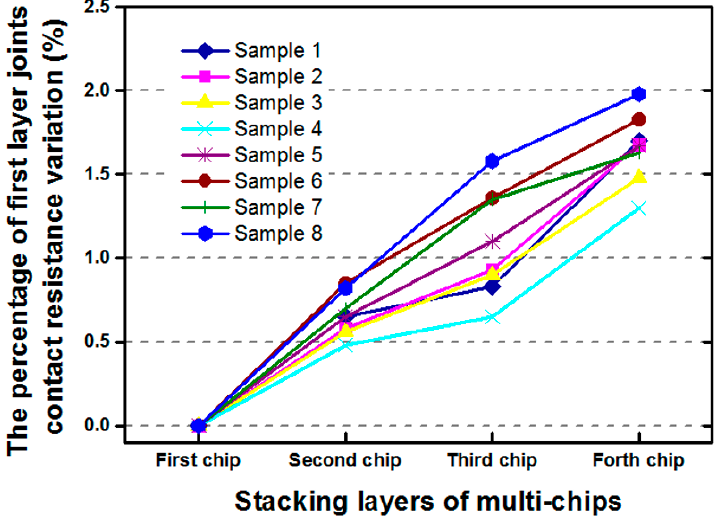
Figure 3. Variation in the contact resistance of the daisy chain at the bottom μ -joint array during multi-chip stacking processes.